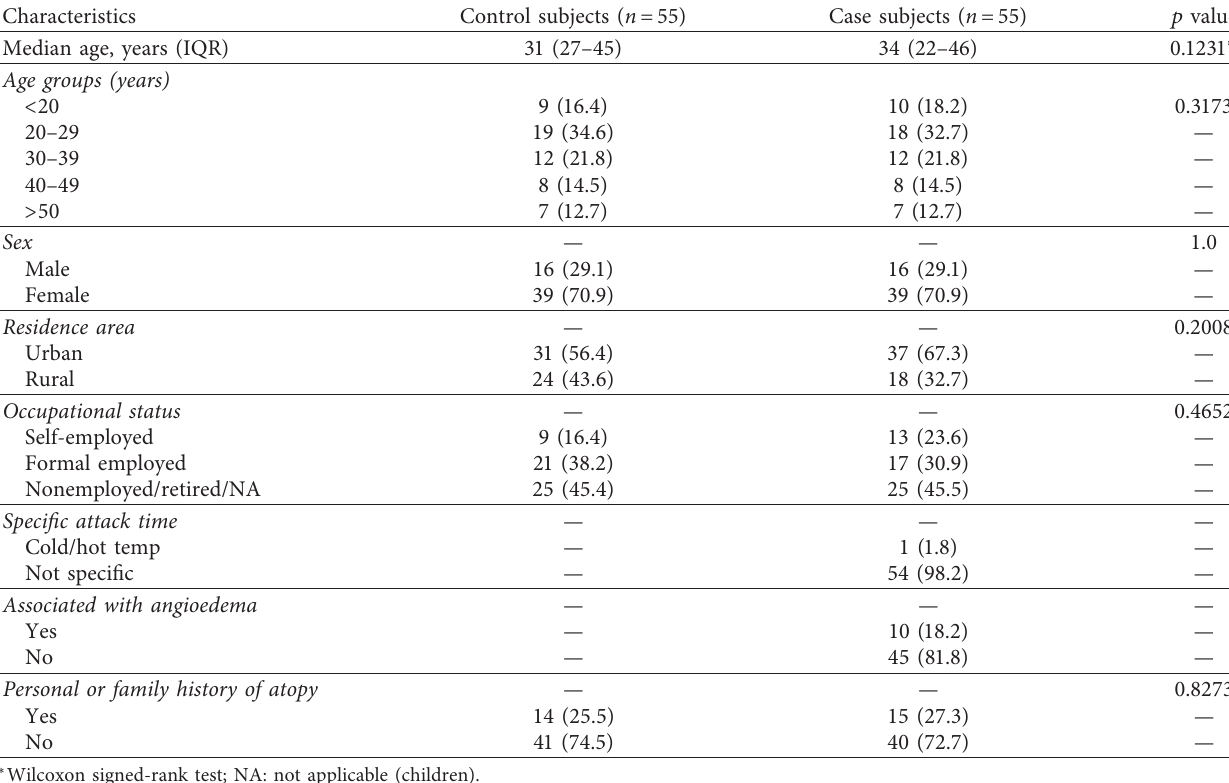
Table 1: Baseline characteristics of case and control subjects after matching.